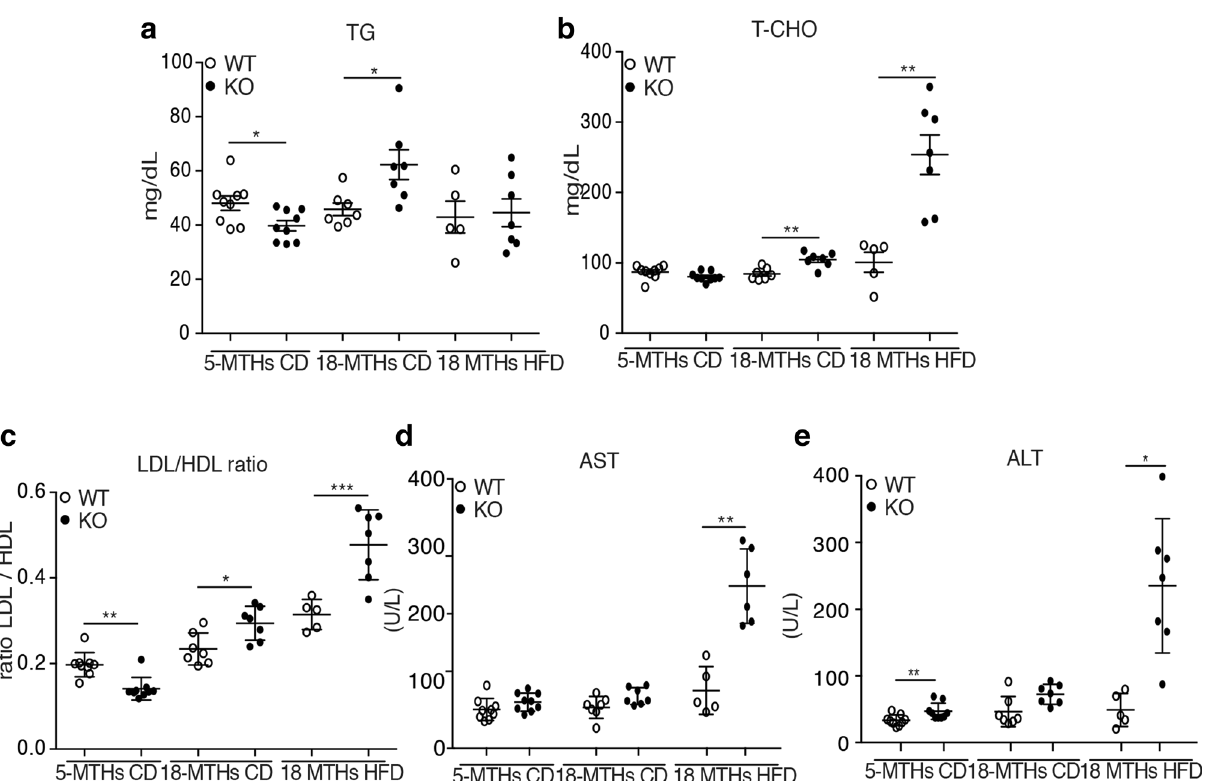
Figure 4. DUSP3 deletion promotes NAFLD and associated liver damages. Concentrations of TG ( a ), T-CHO ( b ), LDL/HDL ratio ( c ), AST ( d ) and ALT ( e ) in the sera of mice. Each dot represents one mouse. Mean ± SD values for all mice are shown. *P < 0.05; **P < 0.01; ***P <